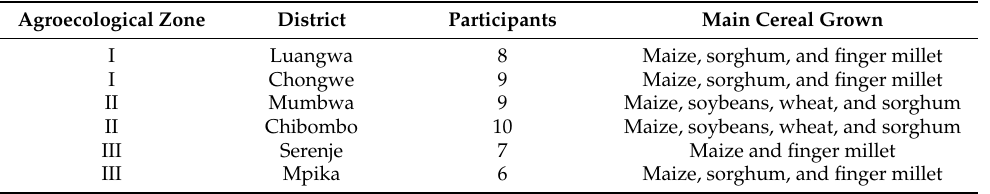
Table 1. A summary of focus groups and main cereal crops